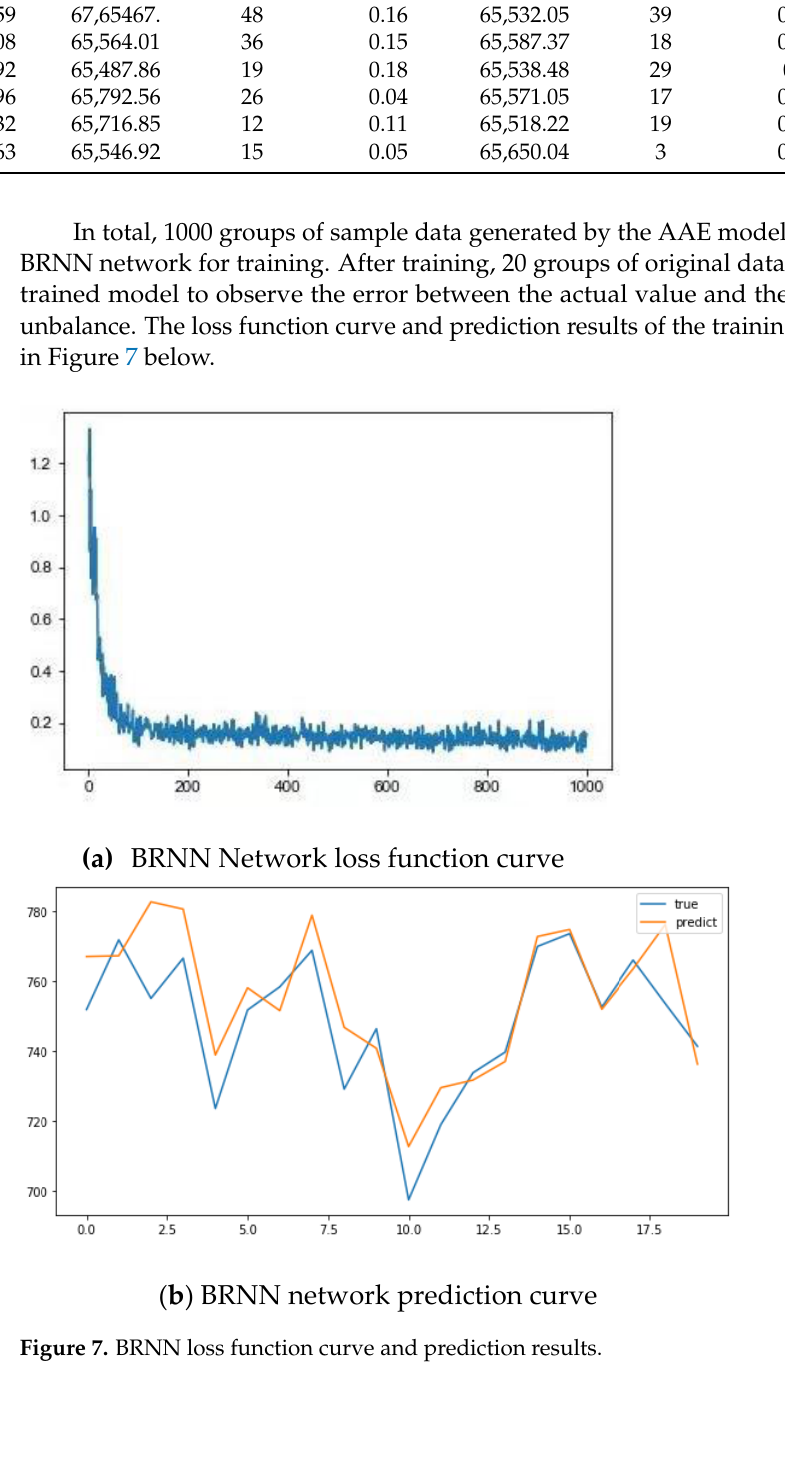
Table 7. AAE generates model results.